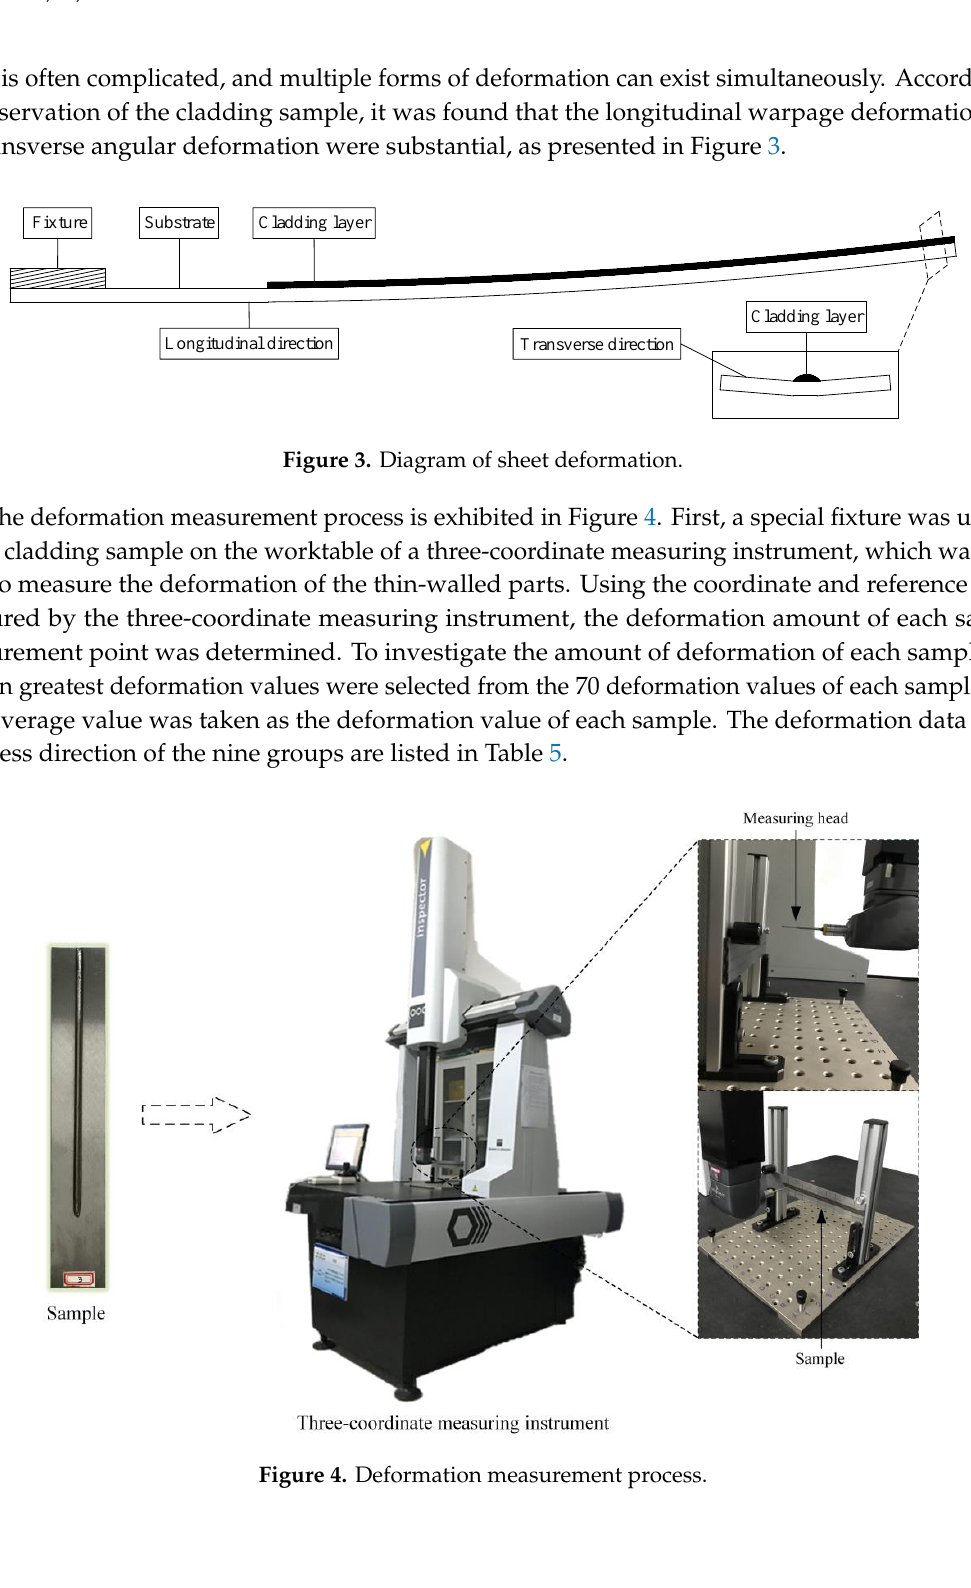
Table 5. Amount of deformation in the thickness direction (mm).